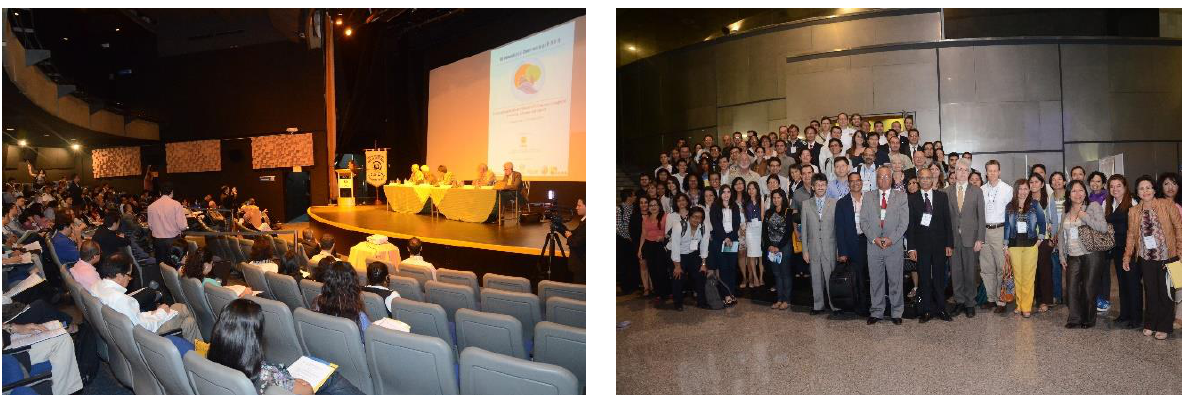
Figure 1. Two moments during the III International Conference on ENSO “Bridging the gaps between global ENSO science and regional processes: extremes and impacts”, Guayaquil (Ecuador) 12–14 November 2014.